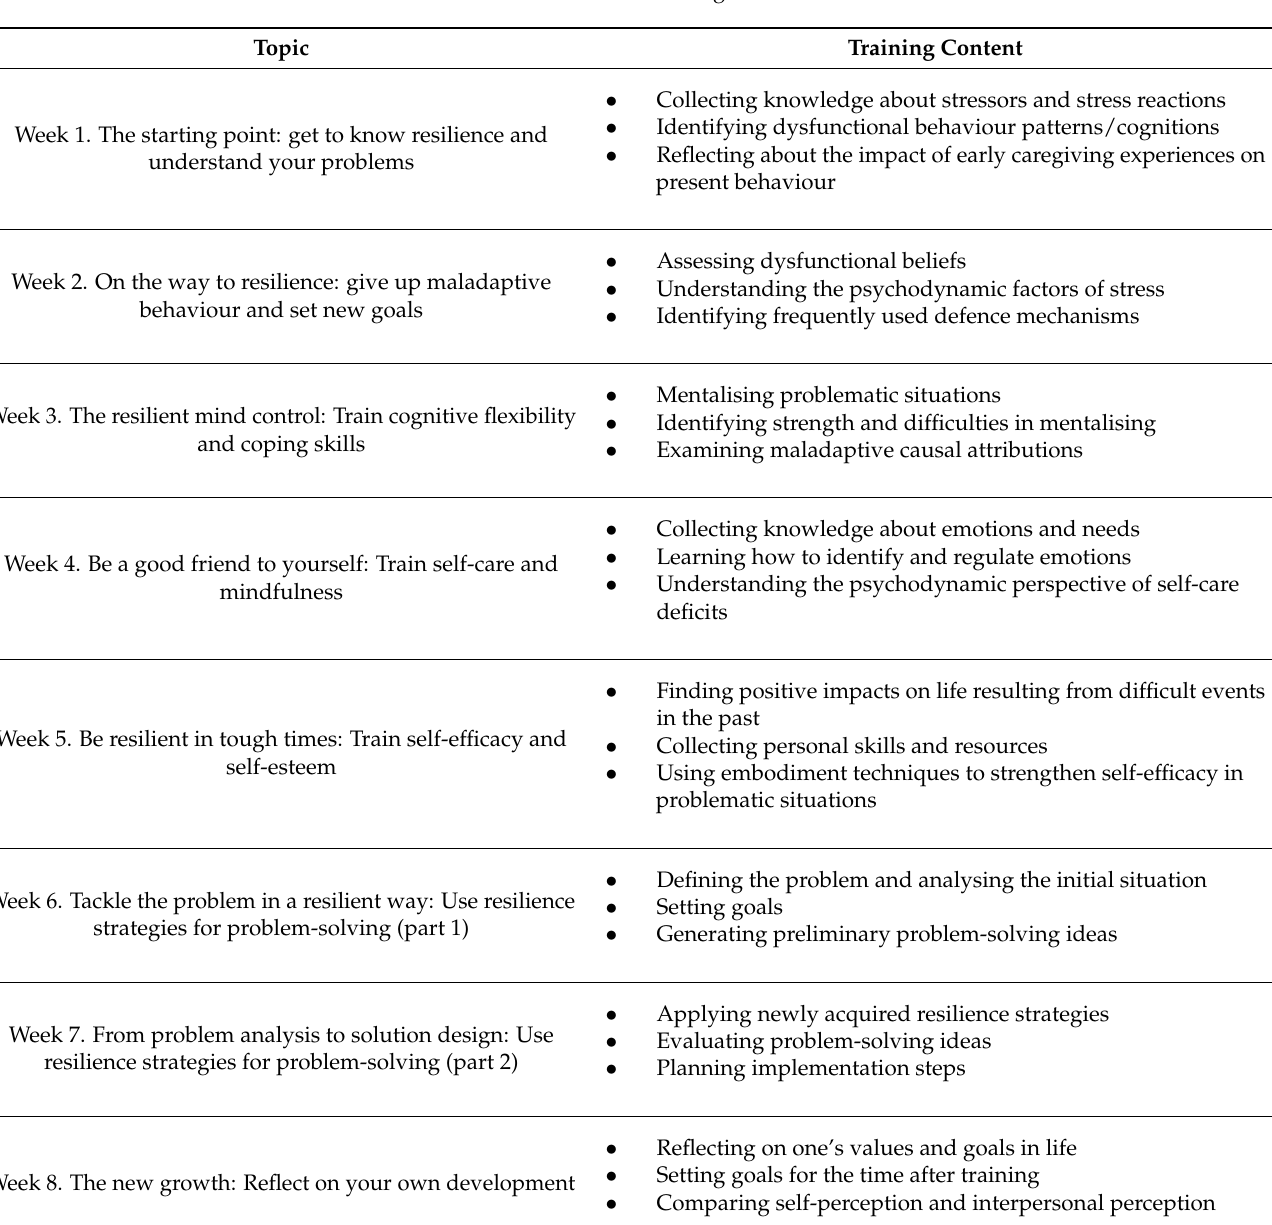
Table A1. Content of the resilience training “The New